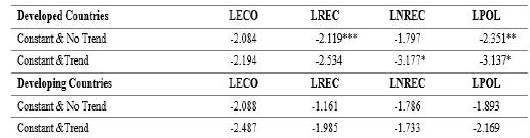
Table 4: Homogeneity Test Results